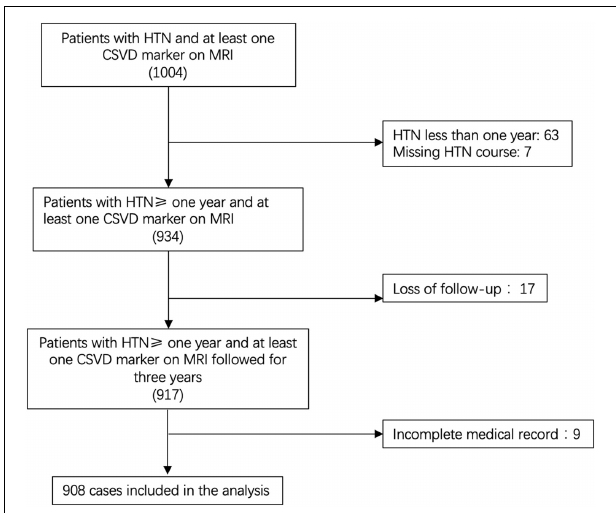
TABLE 2 | Multivariate logistic regression analysis for risk factors of MACCE.